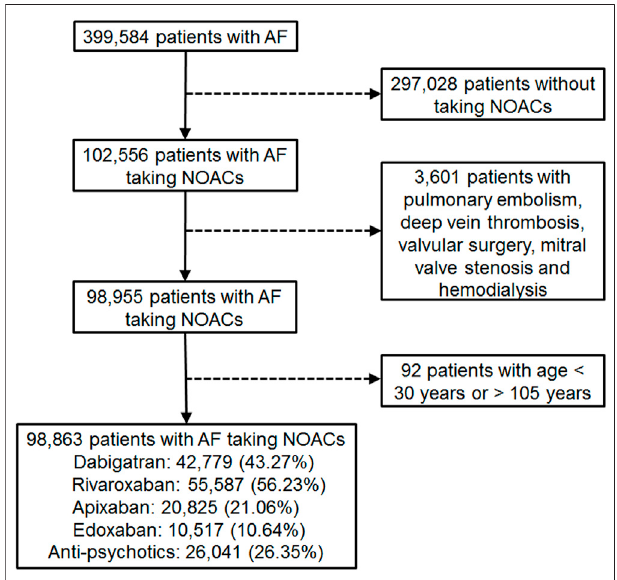
FIGURE 1 | Enrollment of patients with nonvalvular atrial fi brillation (AF) with medication of non-vitamin K antagonist oral anticoagulants